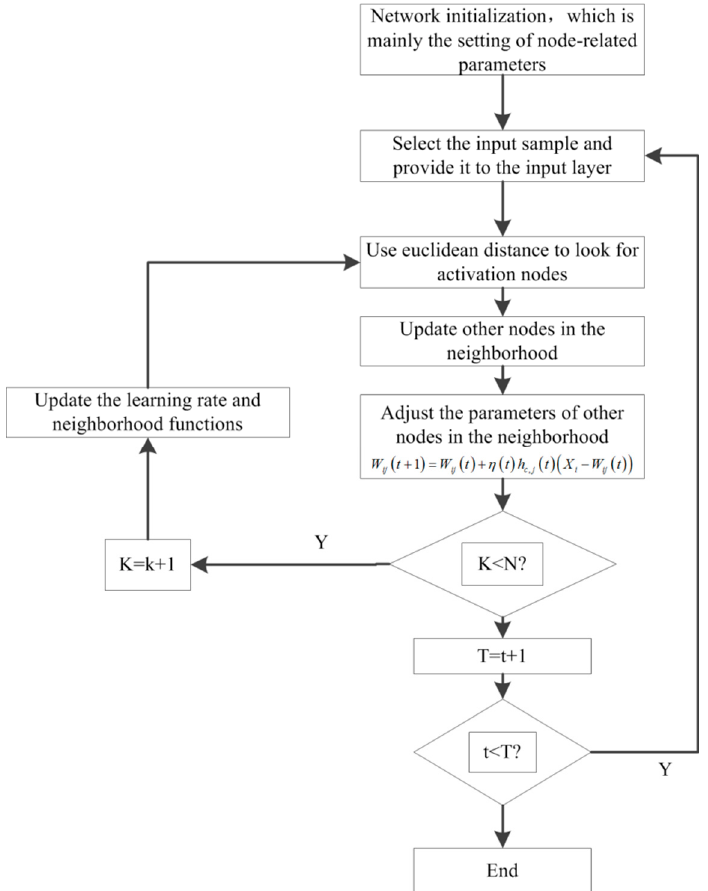
Figure 5. Flow chart of the SOM algorithm.